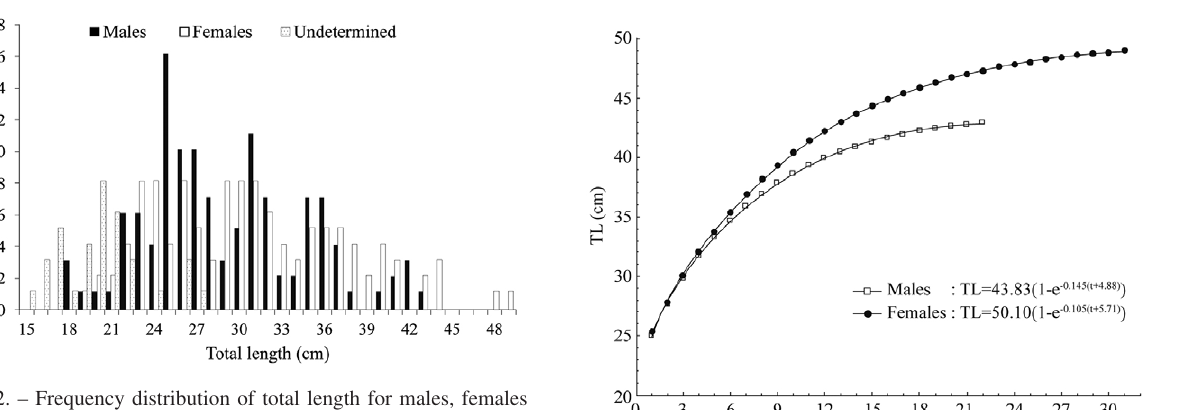
Fig. 2. – Frequency distribution of total length for males, females and individuals with undetermined sex of Sciaena umbra in the Gulf of Tunis. Fig. 5. – von Bertalanffy growth curves for males and females of Sciaena umbra in the Gulf of Tunis.